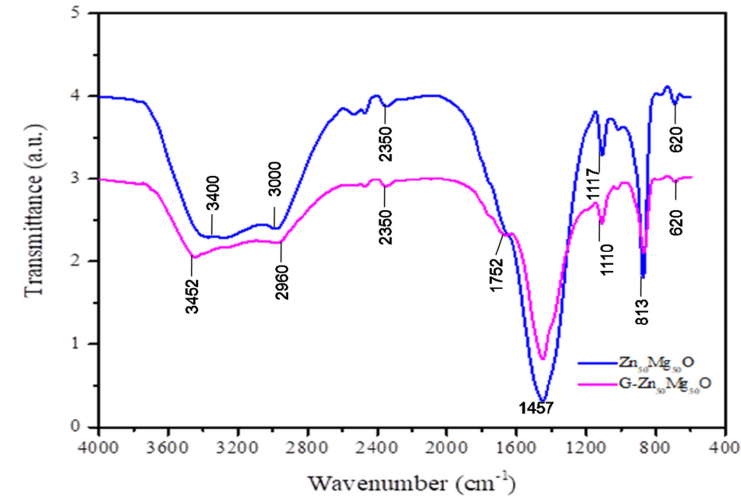
Figure 5. FTIR spectra of Zn 50 Mg 50 O and G-Zn 50 Mg 50 O.